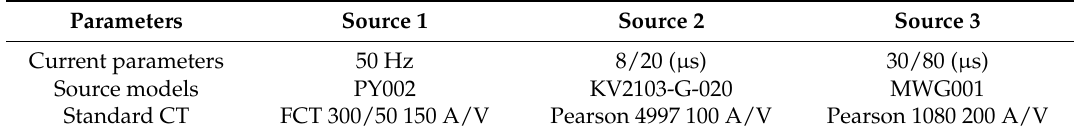
Table 7. Models and equipment parameters.